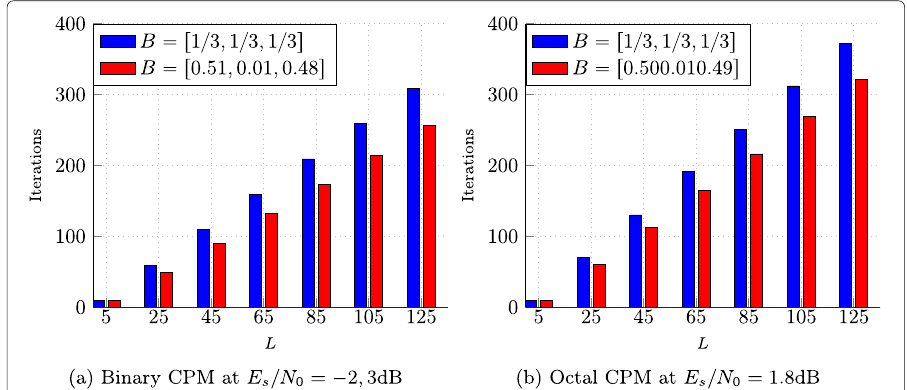
Fig. 9 Iterations before convergence of different SC-CPM schemes with syndrome former memory m s =